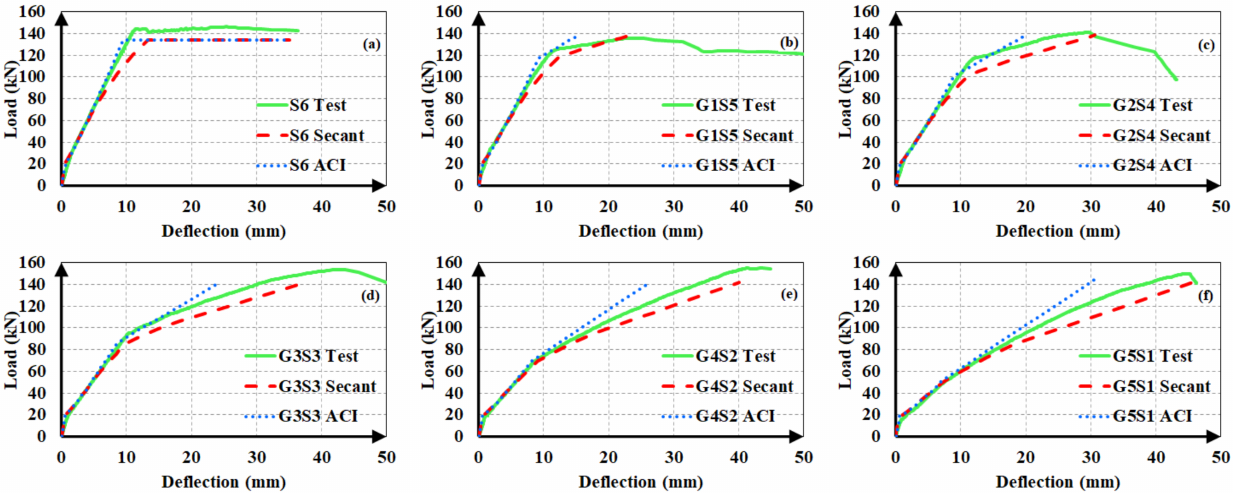
Figure 13. Experimental and analytical load-deflection curves of the second set of beams. ( a ) S6; ( b ) G1S5; ( c )